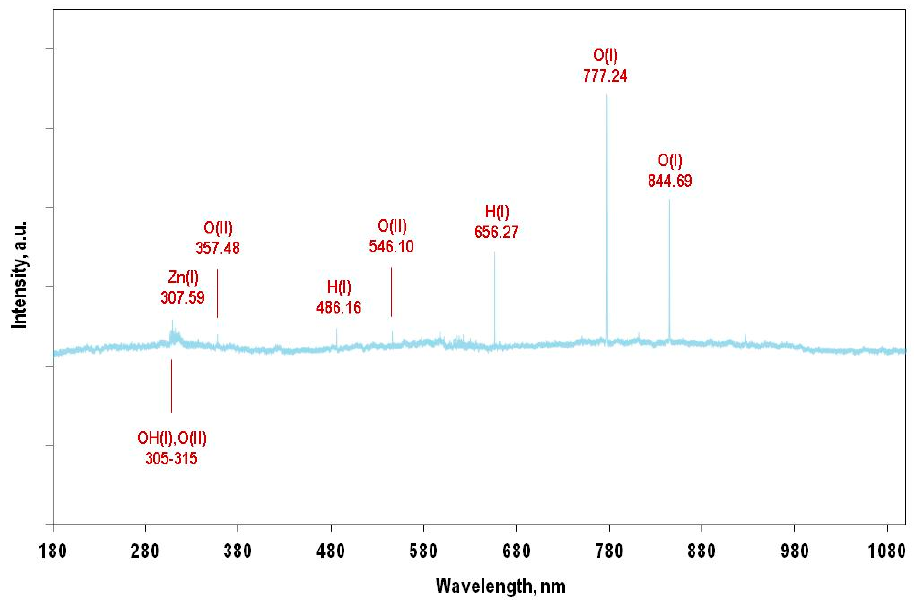
Figure 2. The optical emission spectra of the zinc–hydrogen–oxygen plasma (Zn:H 2 :O 2 = 2:1:1).